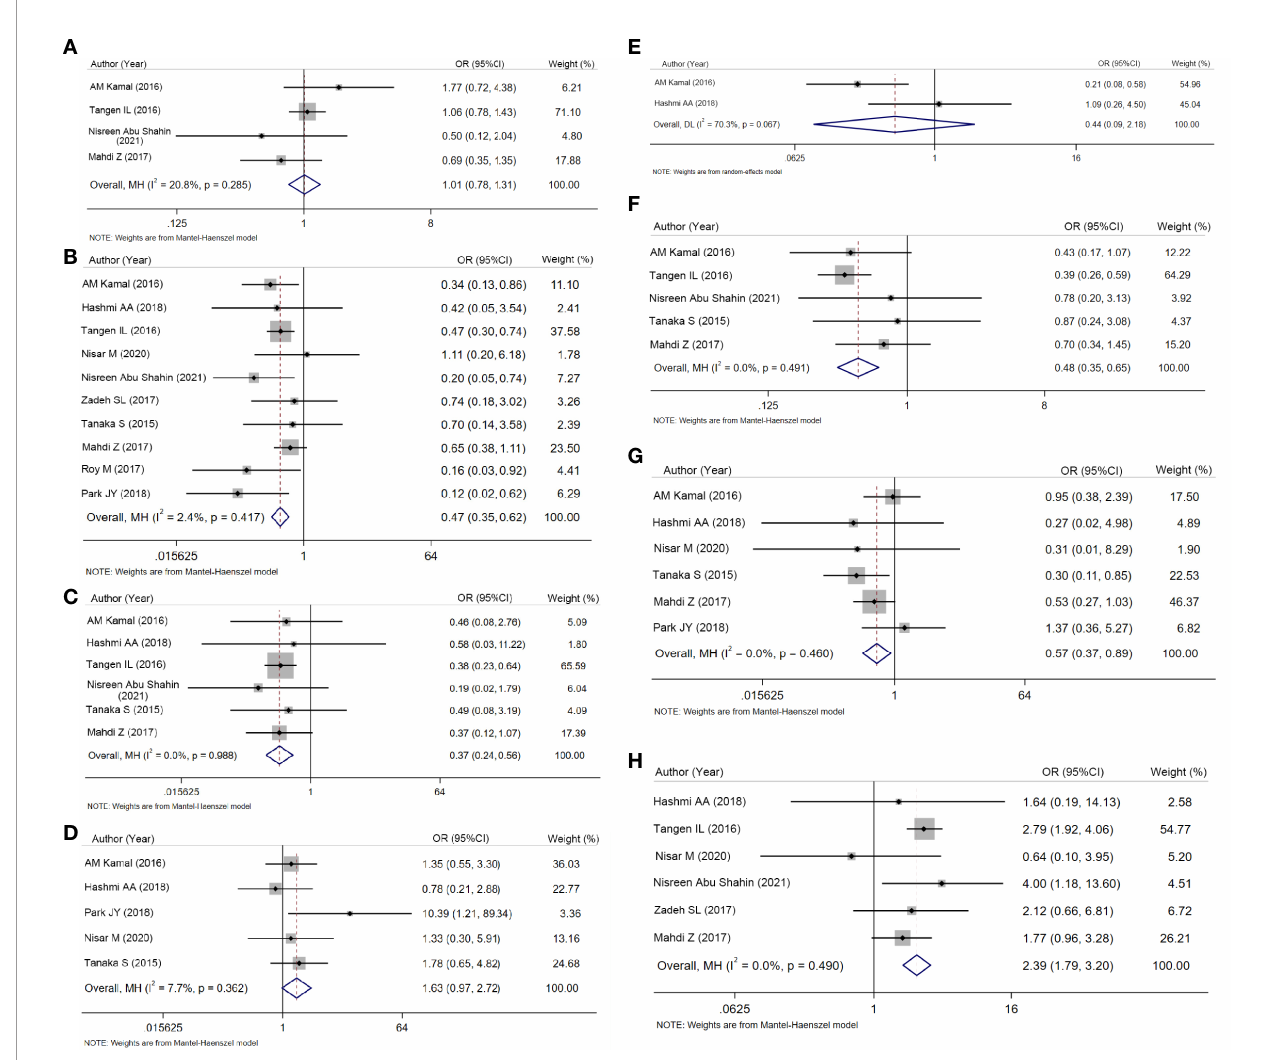
FIGURE 3 | Forest plots for ORs and 95% CIs to compare clinicopathologic characteristics. (A) Age. (B) Grade. (C) Lymph node status. (D) Myometrial invasion. (E) Cervical invasion. (F) Stage (I + II vs. III + IV). (G) Lymphovascular invasion. (H) Histological type (I vs.